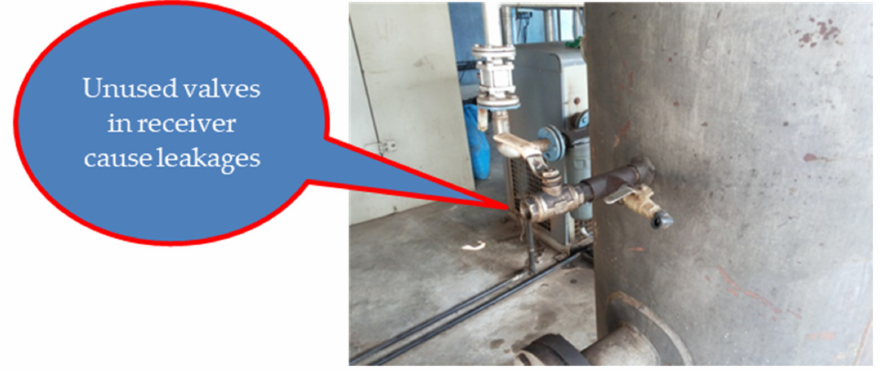
Figure 7. The unused valve which needs to be replaced to avoid